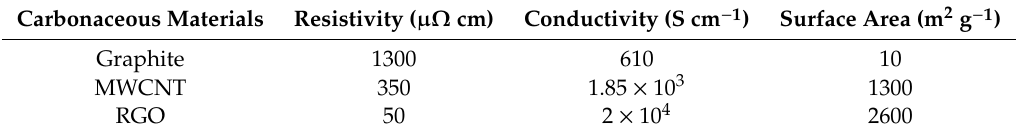
Table 1. Comparison of the properties of the carbonaceous materials, values of the literature [24–28].